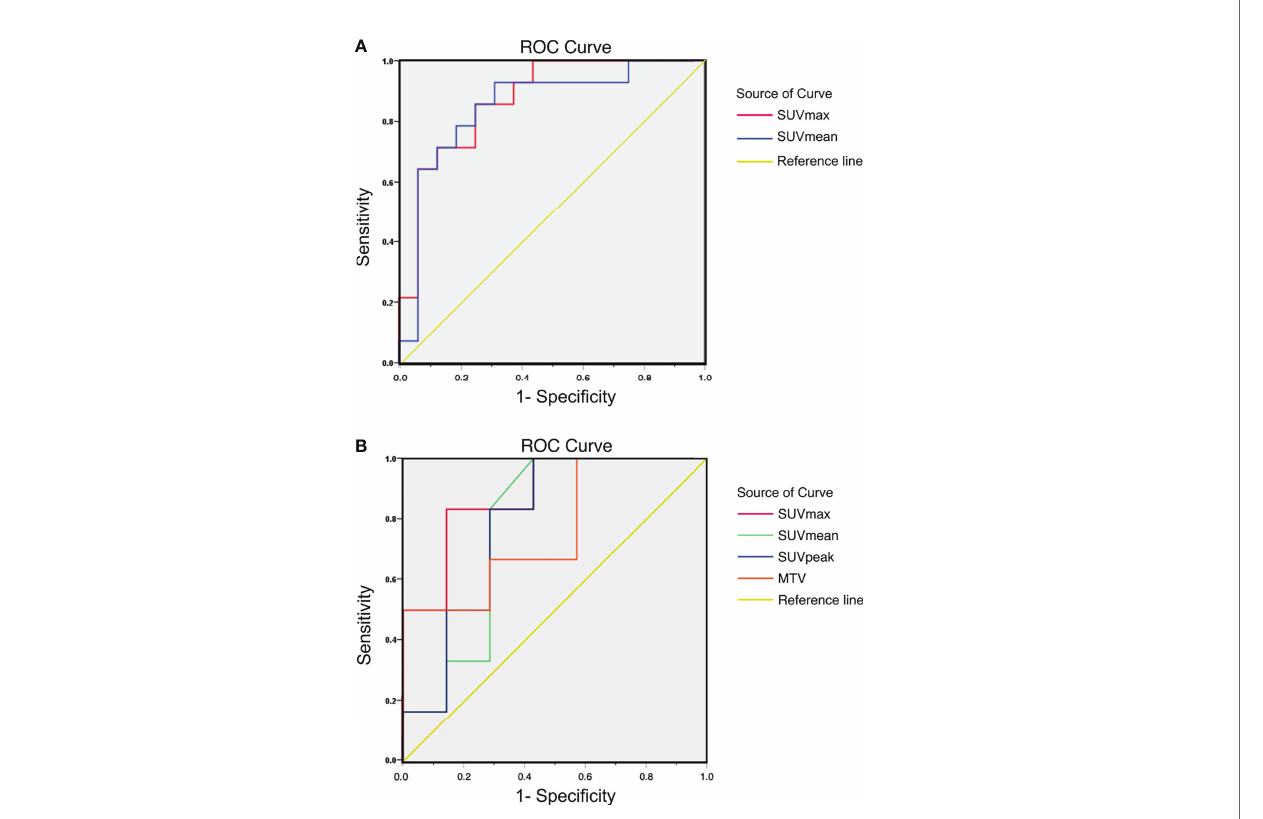
FIGURE 4 | (A) ROC curve of 18 F-RGD PET/CT parameters to re fl ect tumoral PD-L1 expression status (relatively high or low expression) in tumor-bearing mice: AUC of SUVmax and SUVmean were 0.871 (95% CI, 0.743-0.998) and 0.848 (95% CI, 0.699-0.997), respectively; (B) ROC curve of 18 F-RGD PET/CT parameters to re fl ect tumoral PD-L1 expression status (relatively high or low expression) in NSCLC patients: AUC of SUVmax, SUVmean, SUVpeak and GTV were 0.881 (95% CI, 0.692-1.000), 0.774 (95% CI, 0.499-1.000), 0.786 (95% CI, 0.525-1.000) and 0.762 (95% CI, 0.490-1.000)